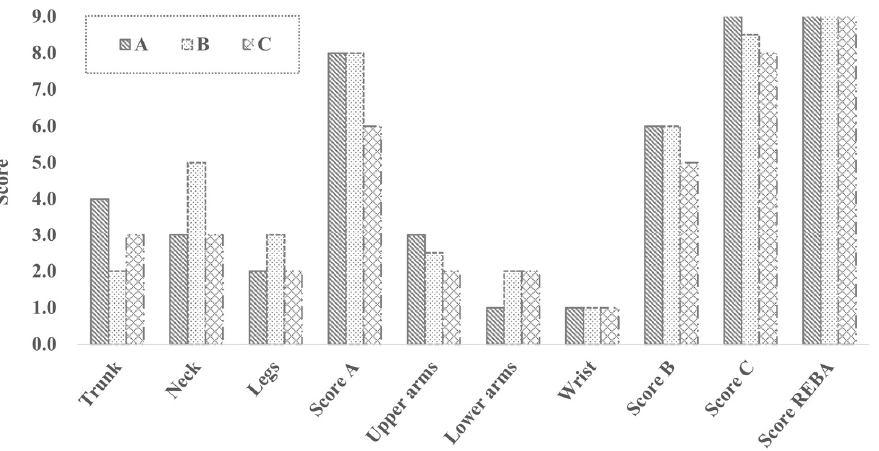
Figure 27. Precision evaluation results of heavy load working posture.